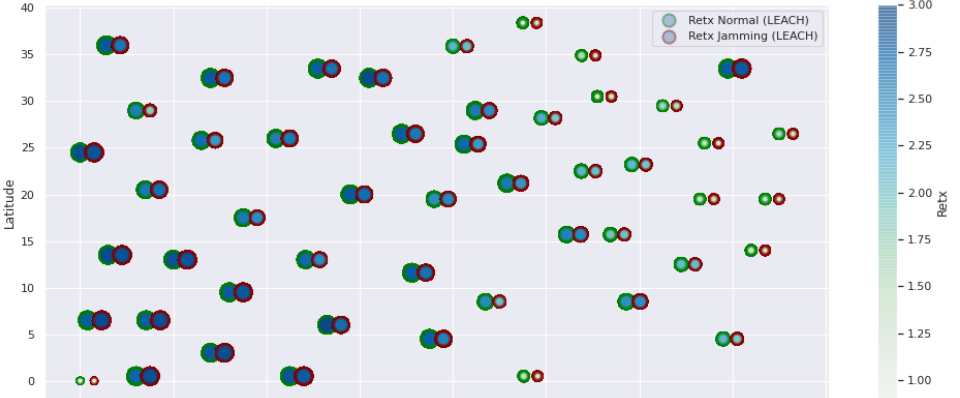
Figure 5. LEACH retransmissions under normal conditions and